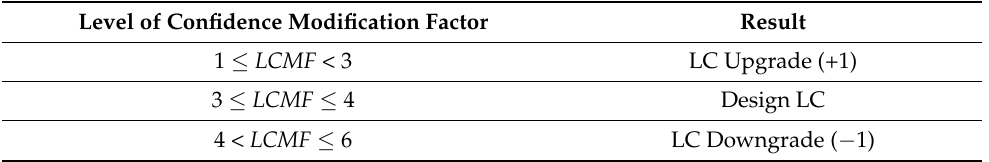
Table 3. Score-based Level of Confidence Modification